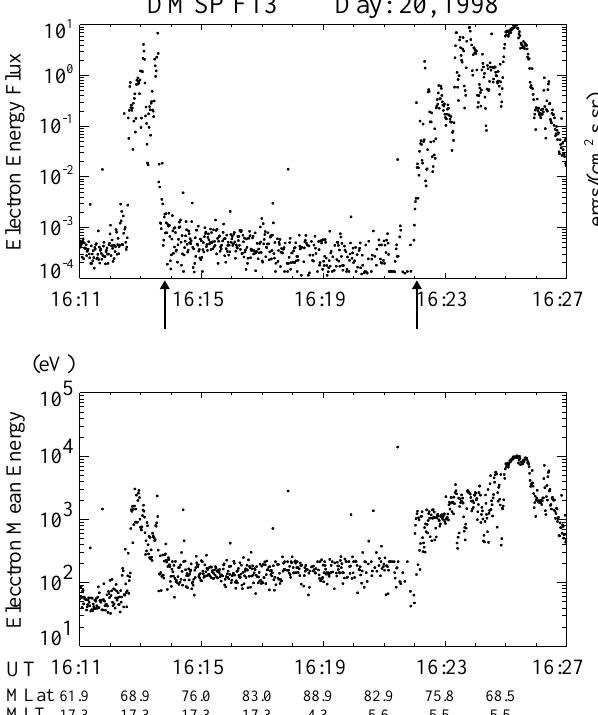
Fig. 3. AplotofDMSPF13totalelectronenergyfluxinergs/(cm 2 ssr) ( top panel ) and electron mean energy in eV ( bottom panel ) from 1611 to 1627 UT on January 20, 1998. The IMF B z is southward during the period. The dusk and dawn polar edges of the auroral oval are shown by arrows